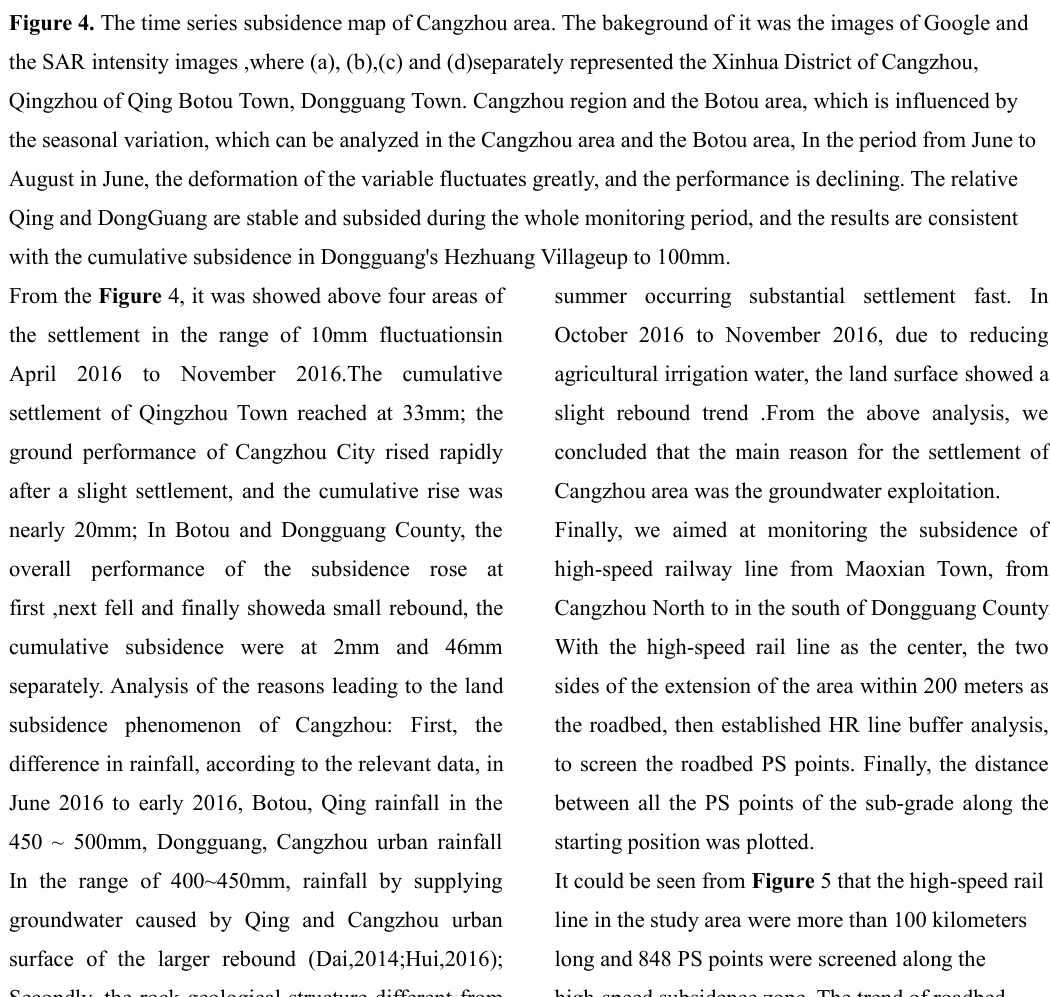
Figure 4. The time series subsidence map of Cangzhou area. The bakeground of it was the images of Google and the SAR intensity images ,where (a), (b),(c) and (d)separately represented the Xinhua District of Cangzhou, Qingzhou of Qing Botou Town, Dongguang Town. Cangzhou region and the Botou area, which is influenced by the seasonal variation, which can be analyzed in the Cangzhou area and the Botou area, In the period from June to August in June, the deformation of the variable fluctuates greatly, and the performance is declining. The relative Qing and DongGuang are stable and subsided during the whole monitoring period, and the results are consistent with the cumulative subsidence in Dongguang's Hezhuang Villageup to